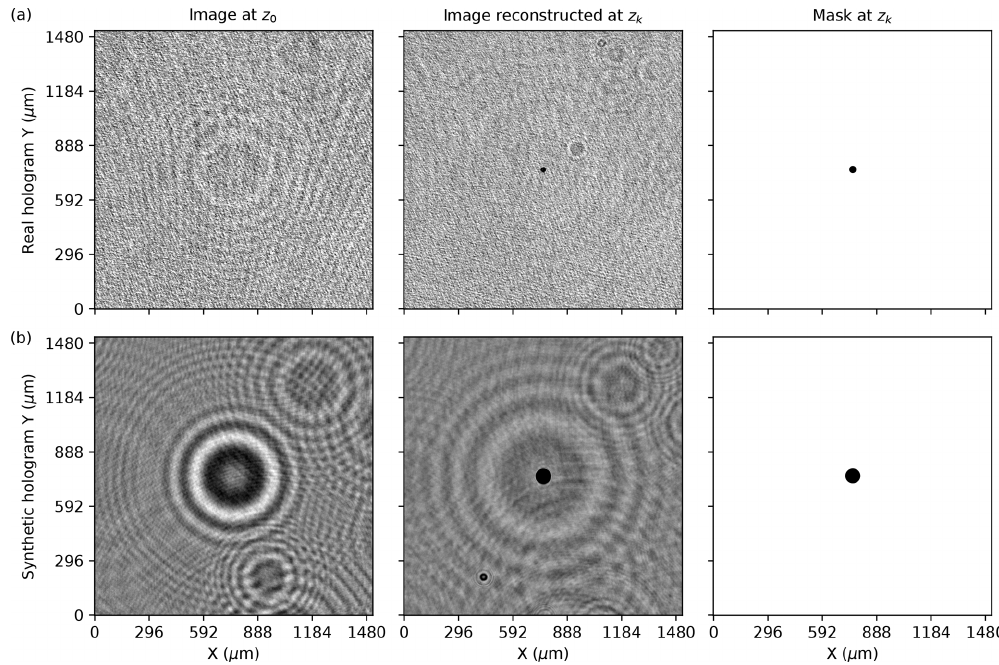
Figure 2. In (a) and (b) the image on the left highlights the particle from Fig. 1 for the HOLODEC and synthetic examples, respectively. The panels in the center column show the same viewpoint of the particles on the left, except that each full-size image from Fig. 1 has been wave propagated to a value of z where the particle is in focus in each example. The pixel color ranges in hologram images in (a) and (b) are the same as in Fig. 1a and b, respectively. In the right column the panels illustrate a “mask” with diameter equal to the particle’s diameter for the HOLODEC and synthetic image in (a) and (b) , respectively. All examples show a dimension of 512 by 512 pixels with pixel values ranging between 0 and